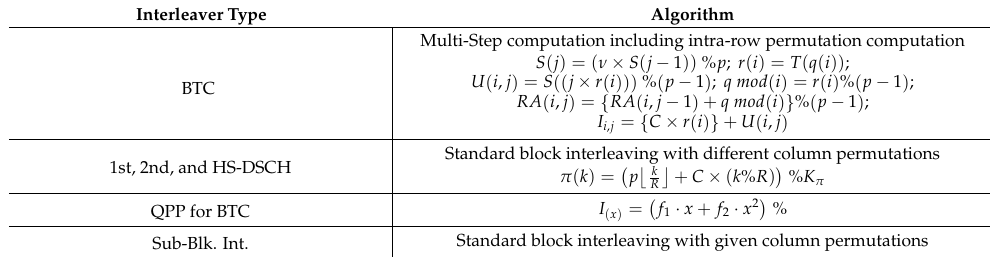
Figure 3. Other interleavers [32]. Table 1. Most of the current interleaver standards